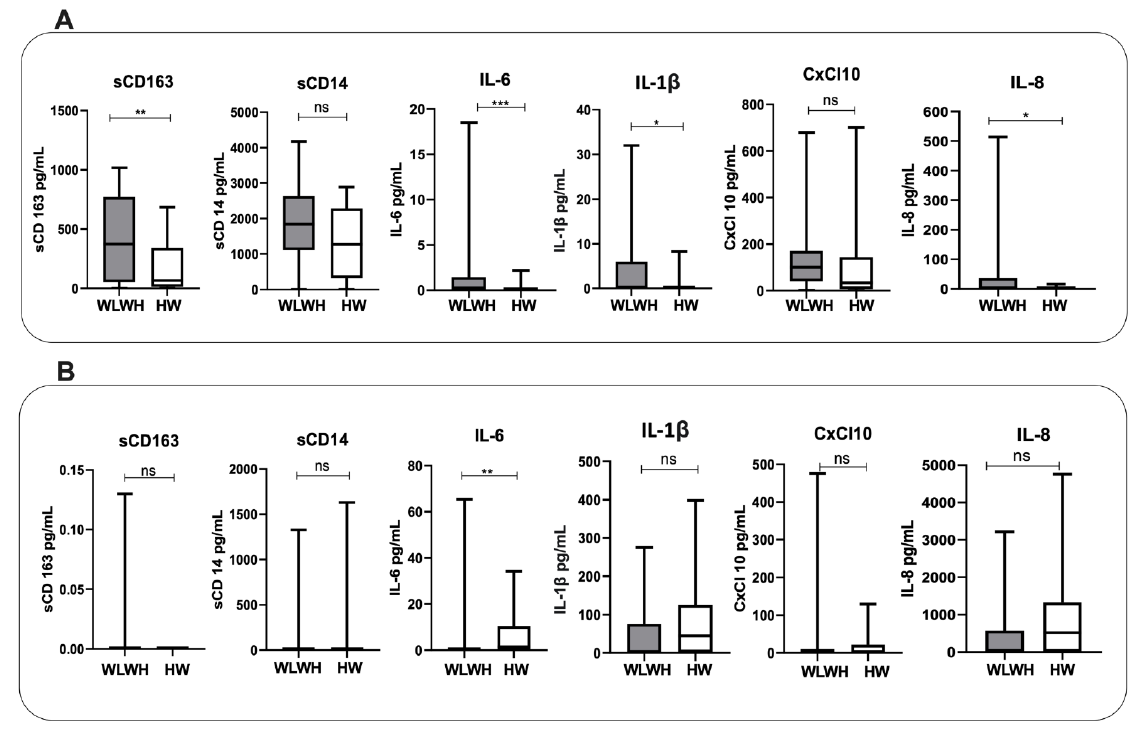
Figure 1. Concentration of proinflammatory biomarkers in WLWH and HW in plasma ( A ) and vaginal lavage ( B ). The differences between the two groups were evaluated using the nonparametric Mann–Whitney test. Data are shown as median (boxplots). Statistical significance ( p ) is reported in the graphics. *** p < 0.001; ** p < 0.01; * p < 0.05.